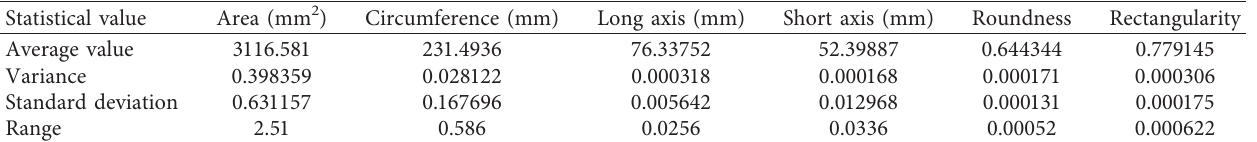
Table 6: Morphological parameter